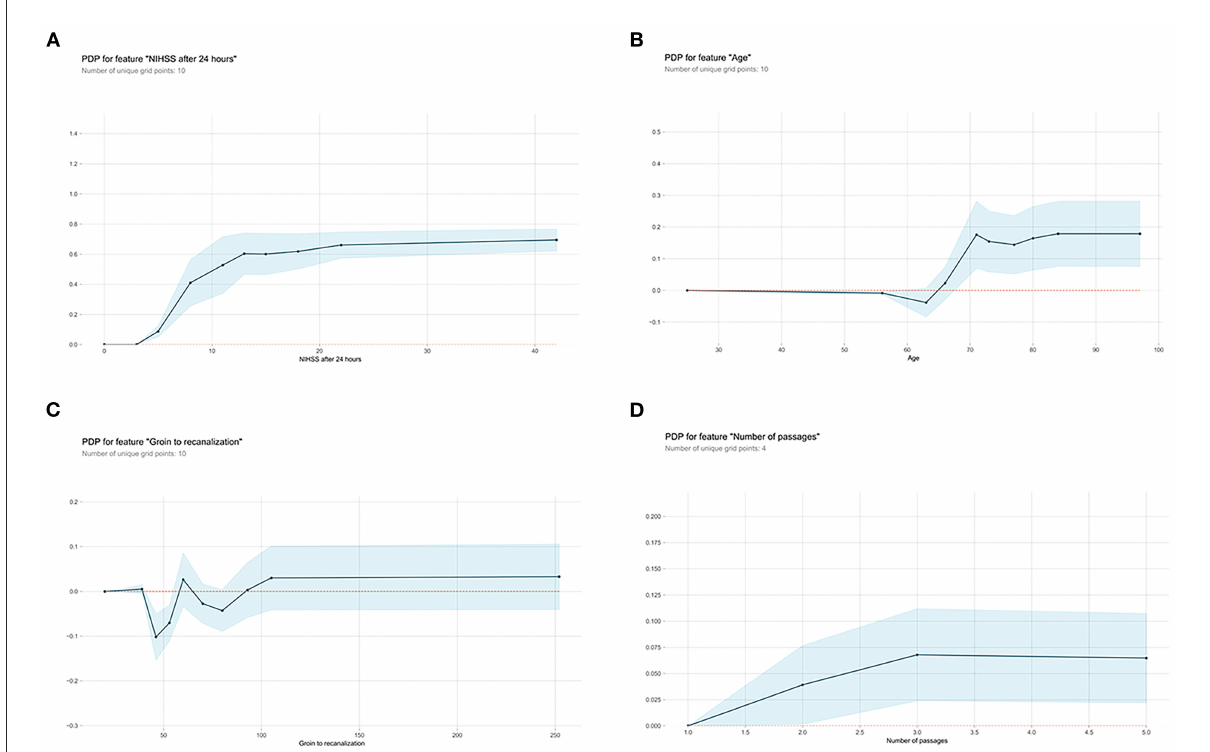
FIGURE3 Partial dependence plots (PDP) of “Late” XGBoost model features. (A) NIHSS after 24 hours, (B) age, (C) groin to recanalization, and (D) the number of passages. The shaded blue region shows the magnitude of the confidence interval, and the Y-axis represents the change in the predicted outcome. NIHSS, National Institutes of Health Stroke